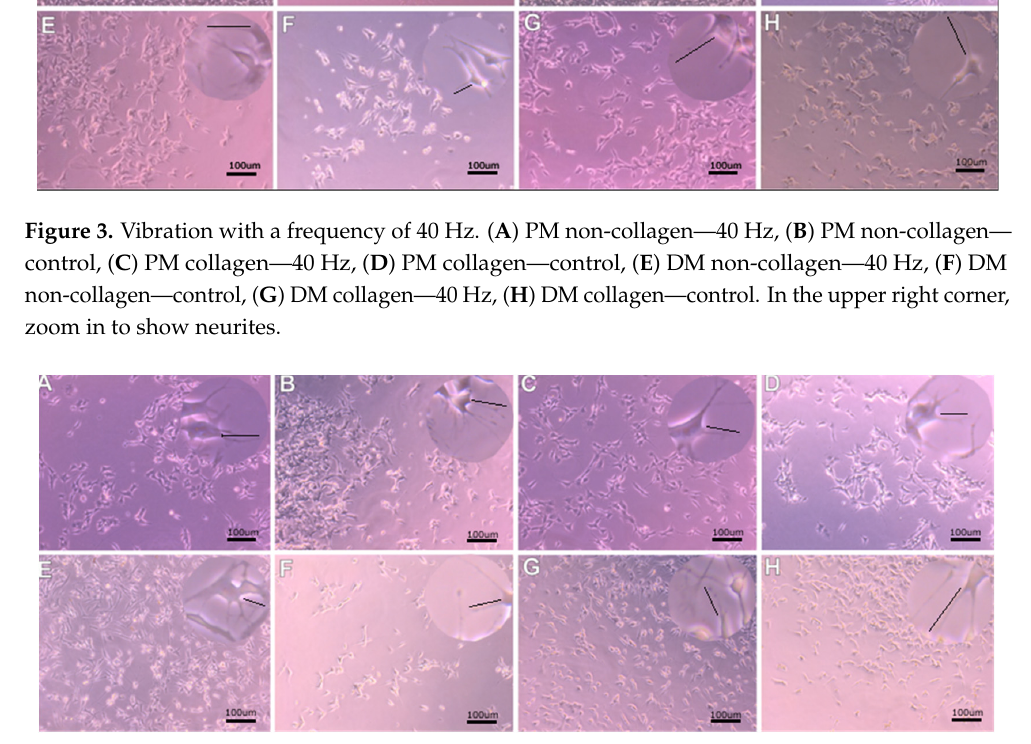
Figure 4. Vibration with a frequency of 100 Hz. ( A ) PM non-collagen—100 Hz, ( B ) PM non-collagen—control, ( C ) PM collagen—100 Hz, ( D ) PM collagen—control, ( E ) DM non-collagen—100 Hz, ( F ) DM non-collagen—control, ( G ) DM collagen—100 Hz, ( H ) DM collagen—control. In the upper right corner, zoom in to show neurites.